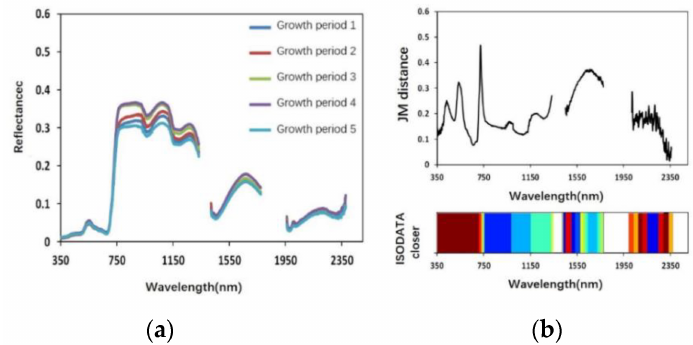
Figure 3. ( a ) Canopy spectra for di ff erent tea plant growth stages; ( b ) the results of band JM distance ISODATA clustering. The same color indicates the same cluster.